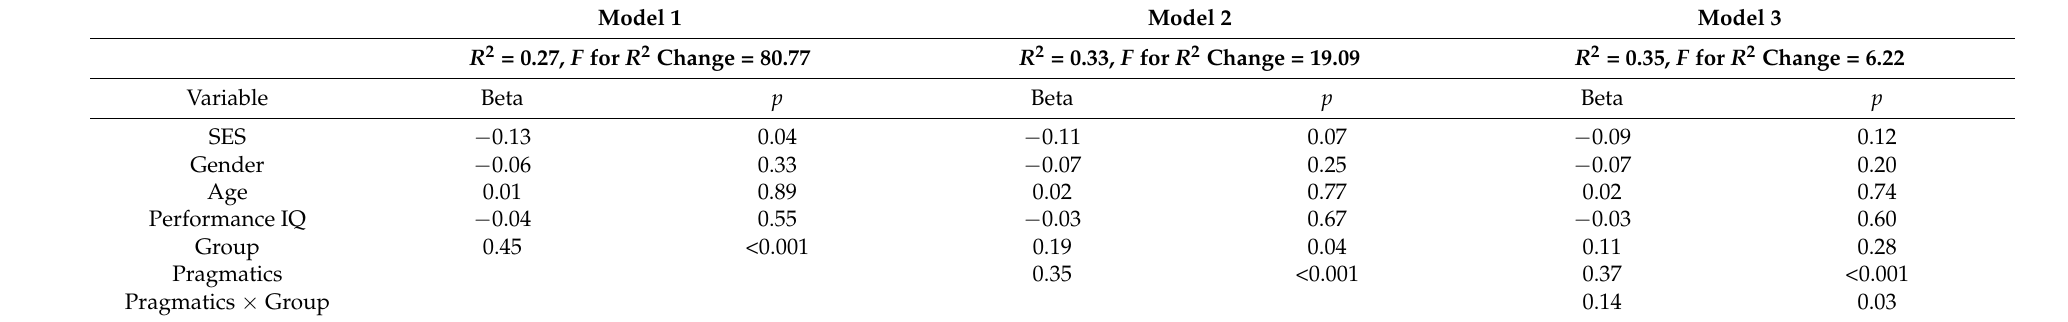
Table 4. Hierarchical regression results for CAM scores.